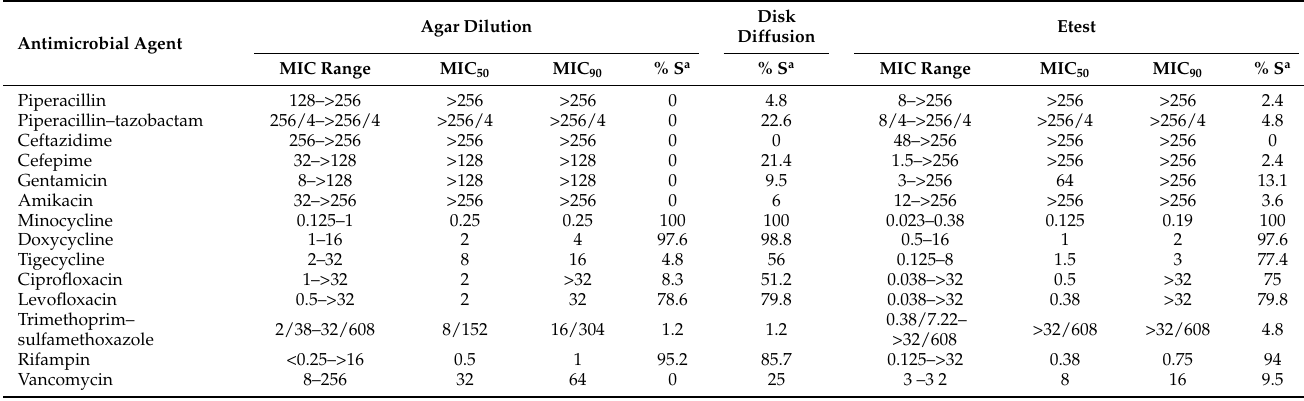
Table 2. Antimicrobial MICs (mg/L) and susceptible rates of 84 E. anophelis isolates determined using the agar dilution, Etest, and disk diffusion methods. Antimicrobial